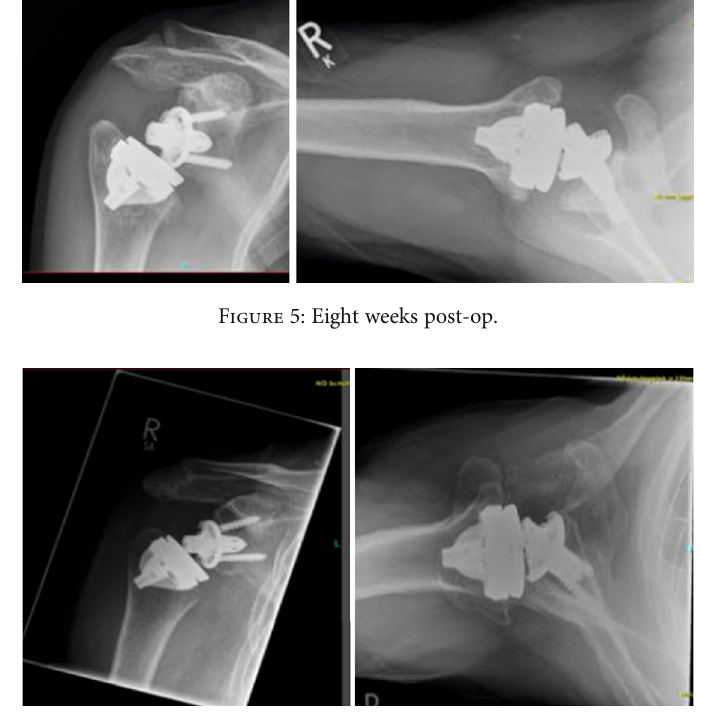
Figure 6: Two-year control.